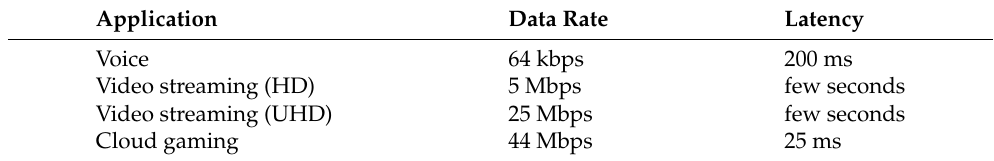
Table 5. Exemplary application